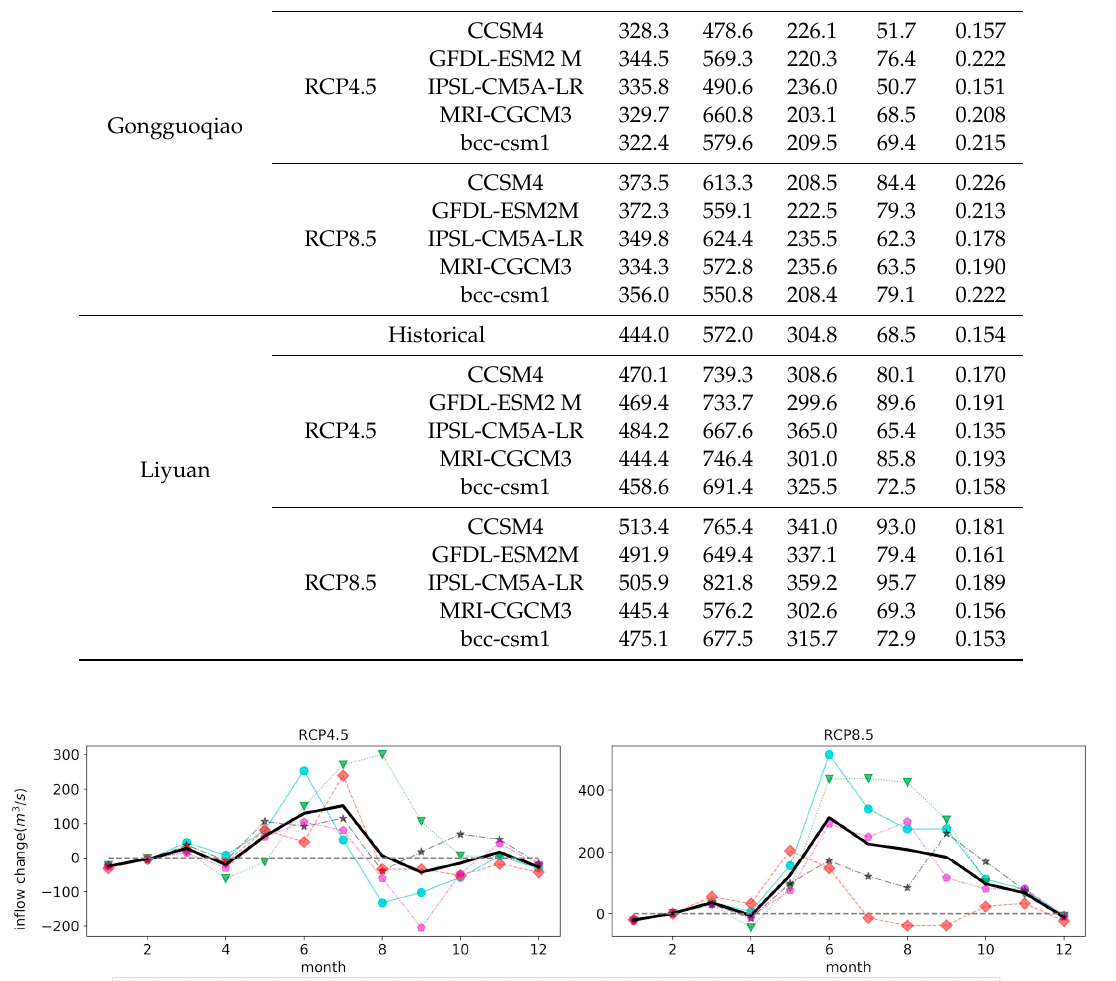
Table 4. The statistics for yearly inflow at typical stations (unit: 10 8 m 3 ).